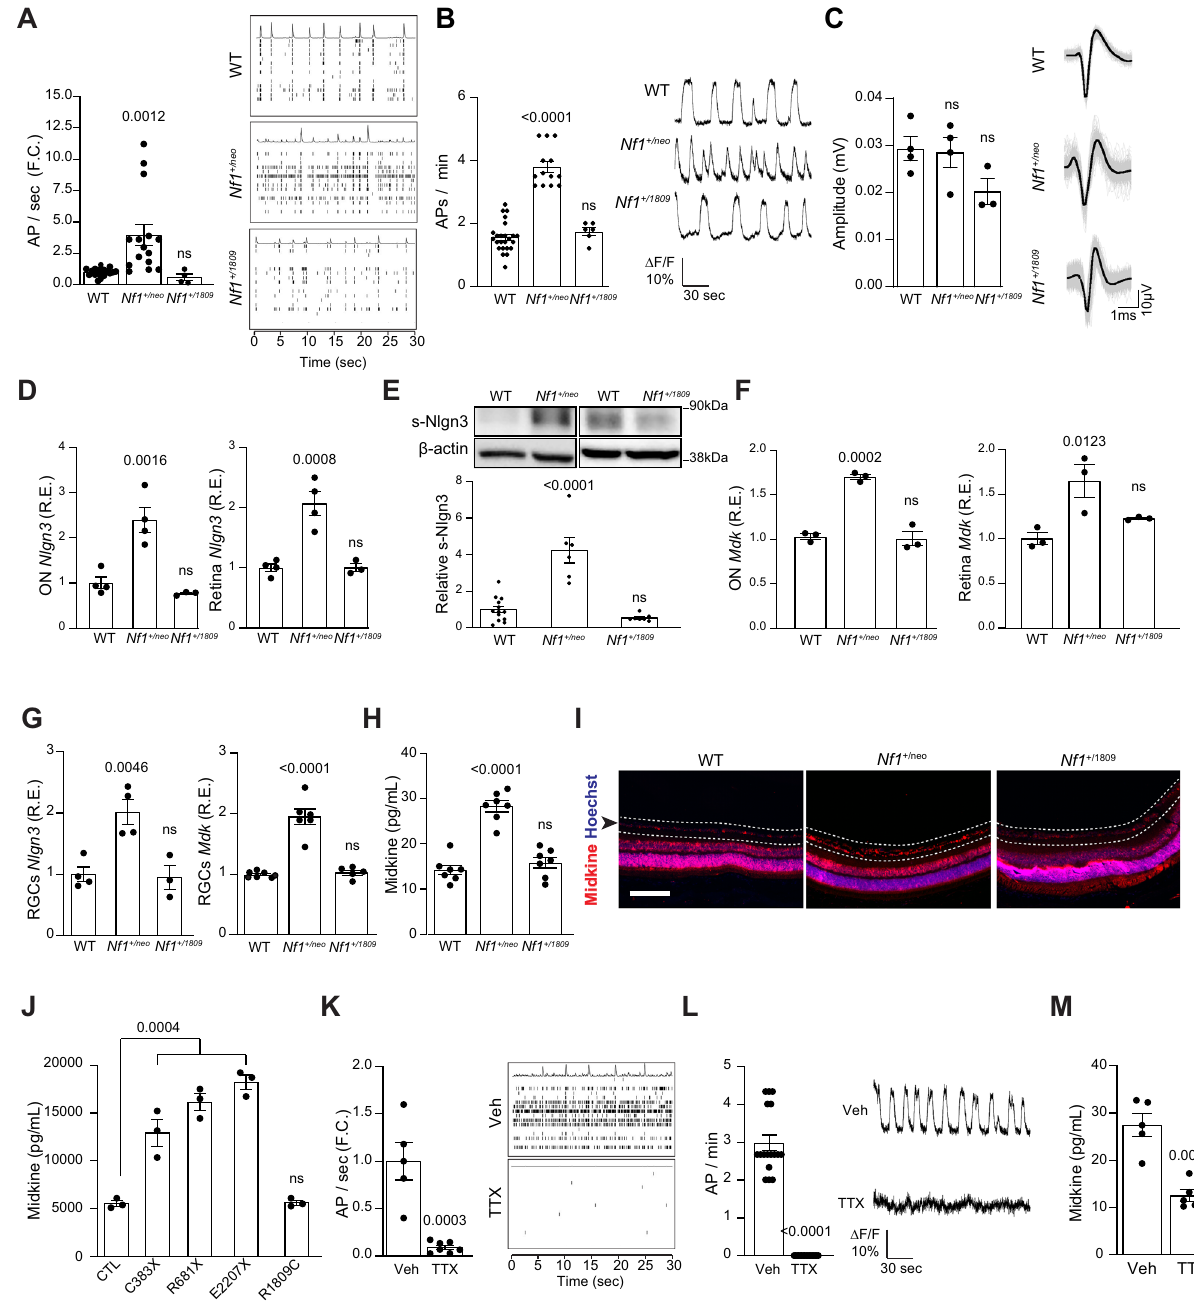
dark cycles or completely in the dark for 4 weeks starting at 4 weeks of age. The retinae of dark-reared animals had decreased levels of Nlgn3 (48% decrease; Fig. 3A) relative to light/dark- reared controls. In stark contrast, retinal Mdk RNA and protein expression were not affected by the decrease in visual experience (Fig. 3B, C), suggesting an alternative mechanism for neuronal activity-dependent midkine production. Based on prior experiments demonstrating that HCN channels control neuronal hyperexcitability and that the Nf1 mutation regulates HCN channel function 37 , we examined the effect of Nf1 mutation on HCN channel function and neuronal excitability. Hcn1 and Hcn2 account for the majority of retinal Hcn channel expression; however, Nf1 mutation ( Nf1 + /neo ) does not alter Hcn